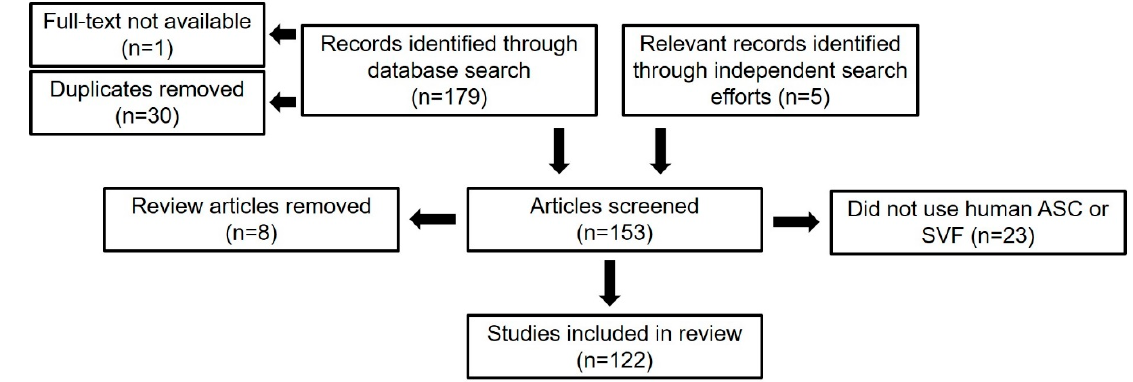
Figure 2. Flow diagram of literature selection process (n = number of articles).